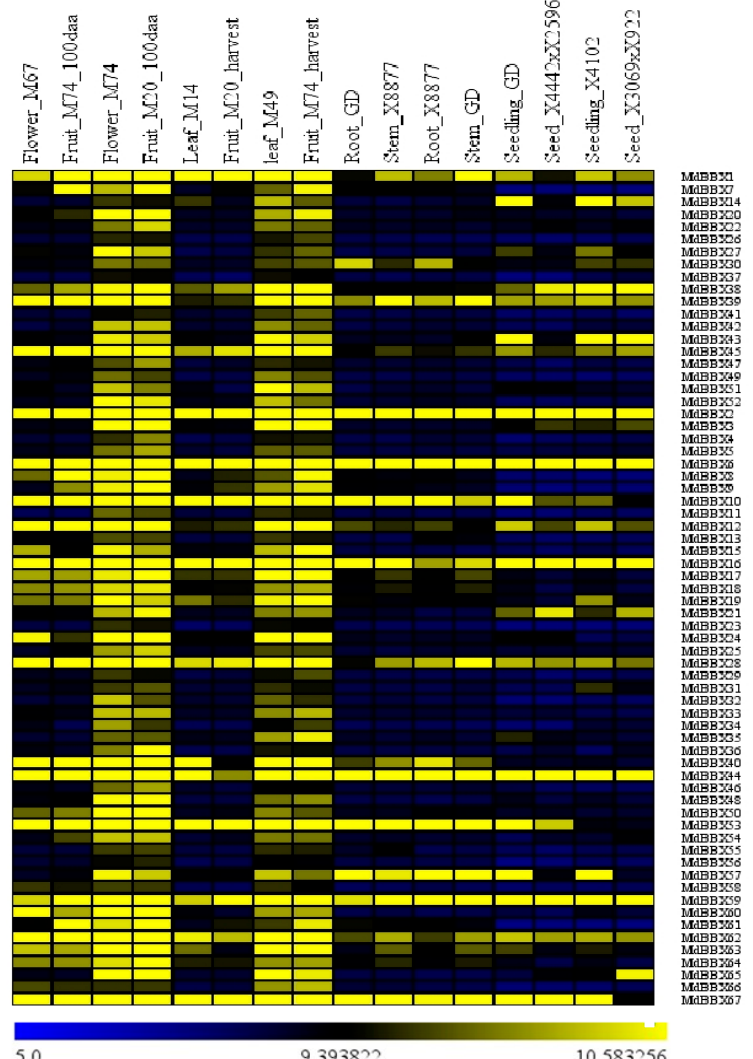
Figure 7. The expression profiles obtained from the ArrayExpress data, displaying diverse expression levels of apple BBX genes in different tissues and organs. The relative transcript level of BBX genes members based on ArrayExpress data was presented as heat maps from blue to yellow reflecting relative signal values; where dark blue boxes represent stronger downregulated expression and dark yellow boxes represent stronger up-regulation. 100daa referred for 100 days postanthesis, GD stand for Golden Delicious’ seedling, M74 indicating Hybrid M74, M49 indicated M49 hybrid, M20 indicated M20 hybrid, M14 indicated M14 hybrid, X8877 indicated X8877 hybrid, and X4442 and X2596 referred the cross between X4442 and X2596